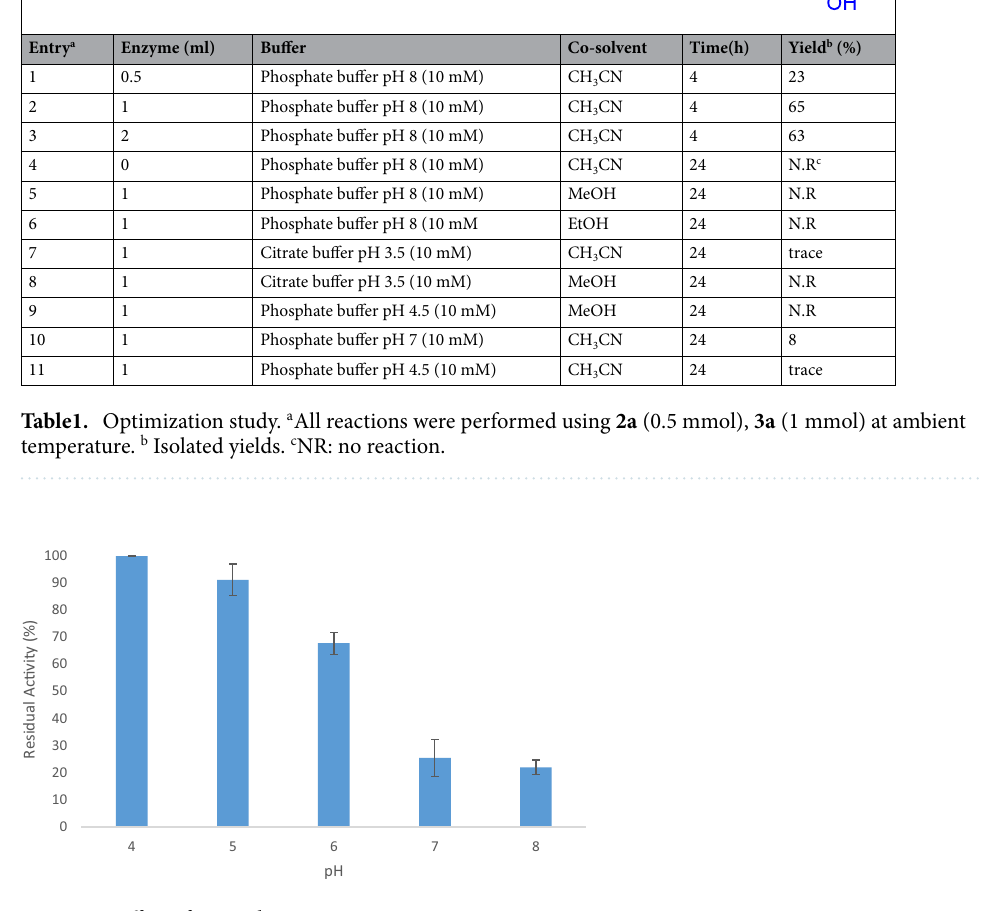
Figure 3. Effect of pH on laccase